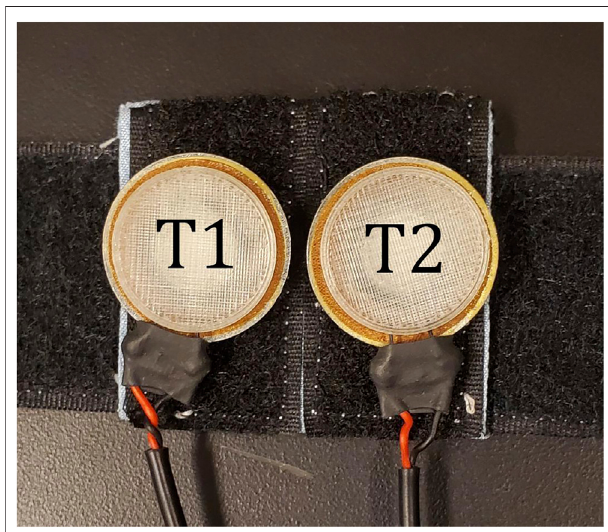
FIGURE 1 | The two tactors used in the experiment. A white 3D-printed plasticdiskisattached totheunderlying adhesiveringconnectedtothetactor diaphragm (visible as an orange border around the plastic disk).